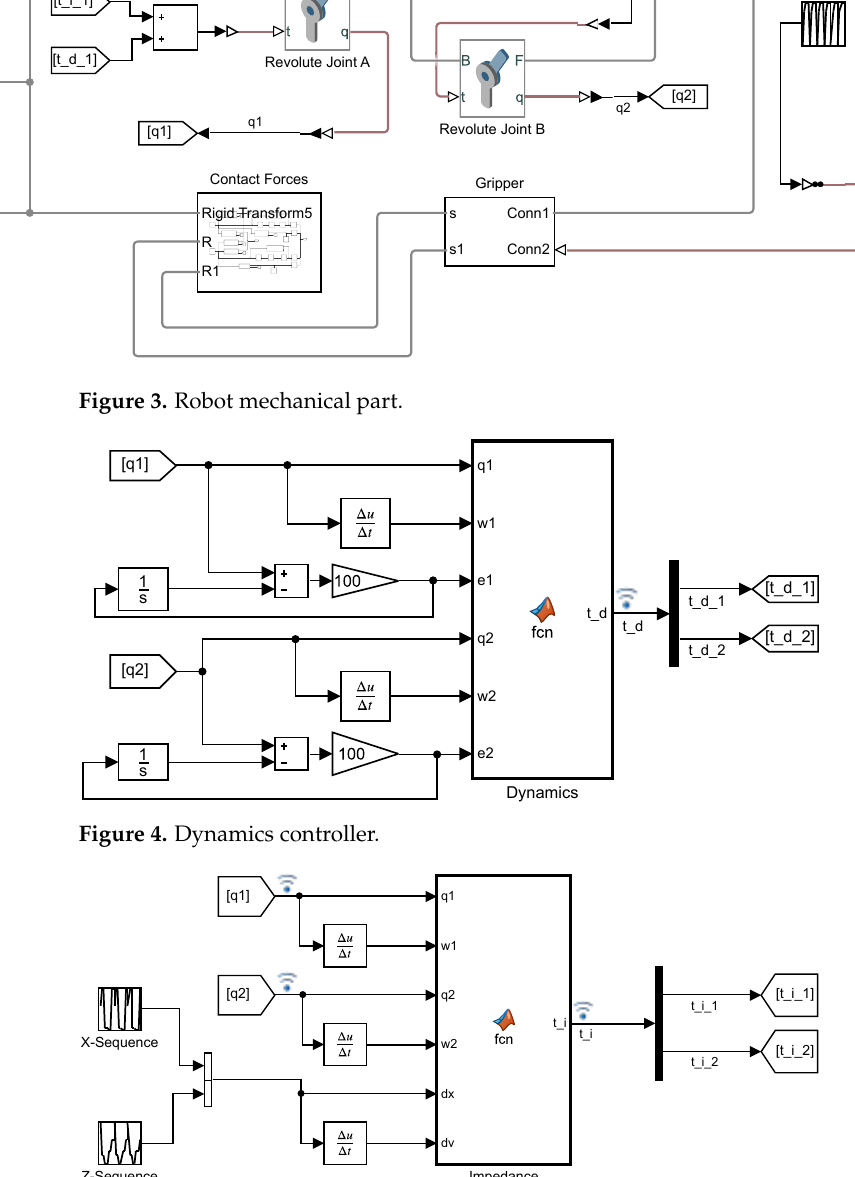
Figure 5. Impedance